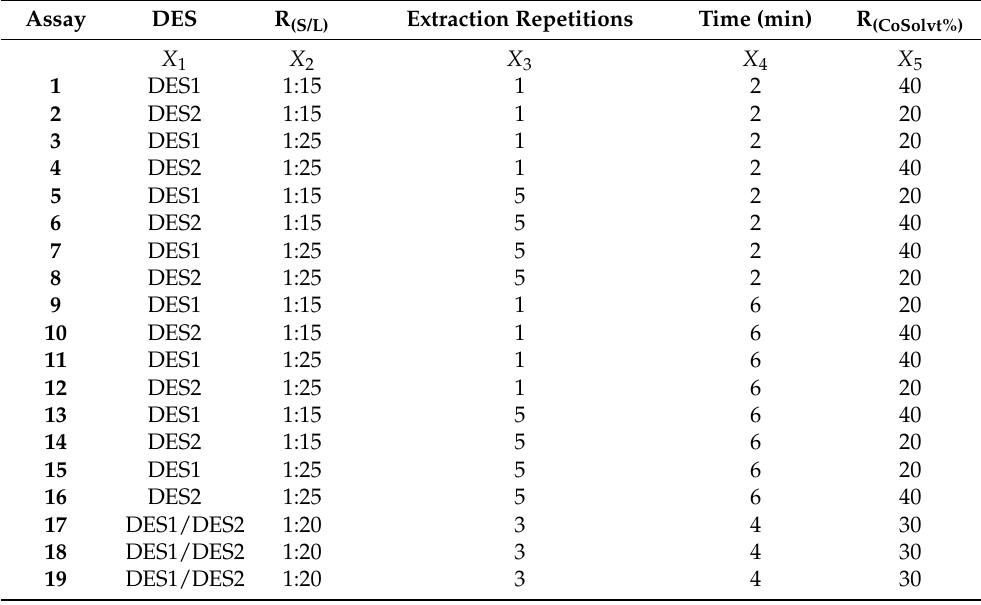
Table 2. Independent variable values of fractional factorial experimental design (2 5-1 ) with three central points for DES1 and DES2 were used as independent variables as well as R (S/L) , Repetitions, time, and R (CoSolvt%) . Assay